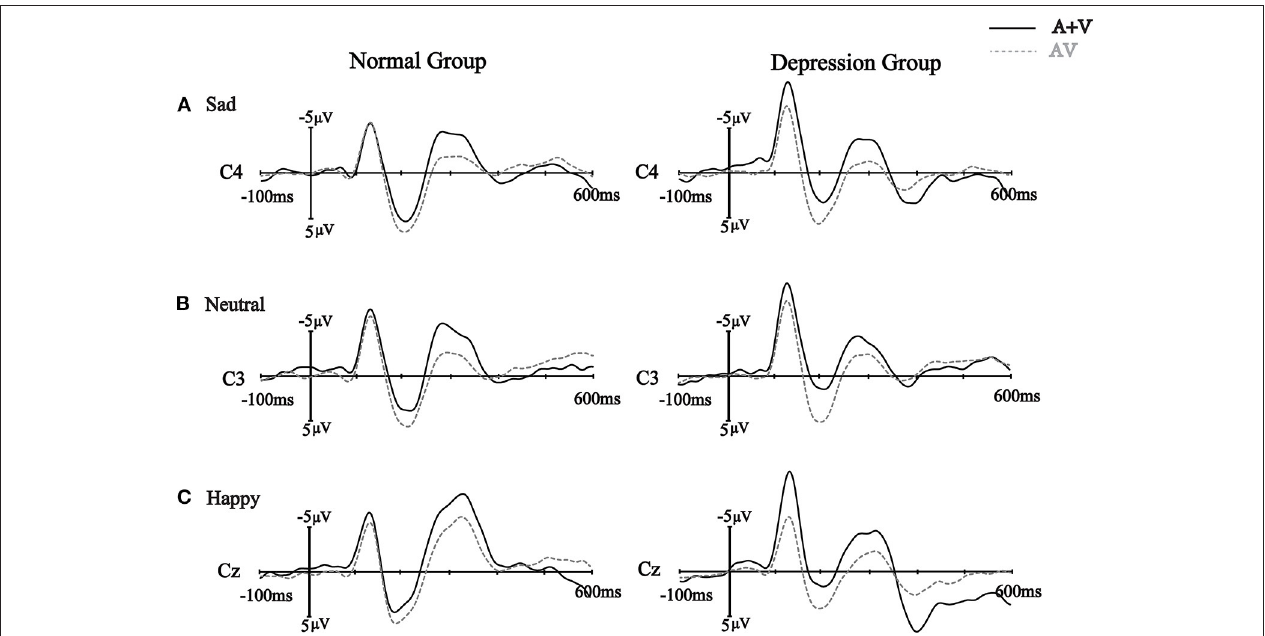
FIGURE 2 | The sum of the event-related potentials of the unimodal stimuli (A + V) and the event-related potentials of the bimodal stimuli (AV) from a subset of electrodes are shown from 100ms before to 600ms after stimulus onset in the different groups with the different emotional stimuli (A) sad emotional stimuli, (B) neutral emotional stimuli and (C) happy emotional